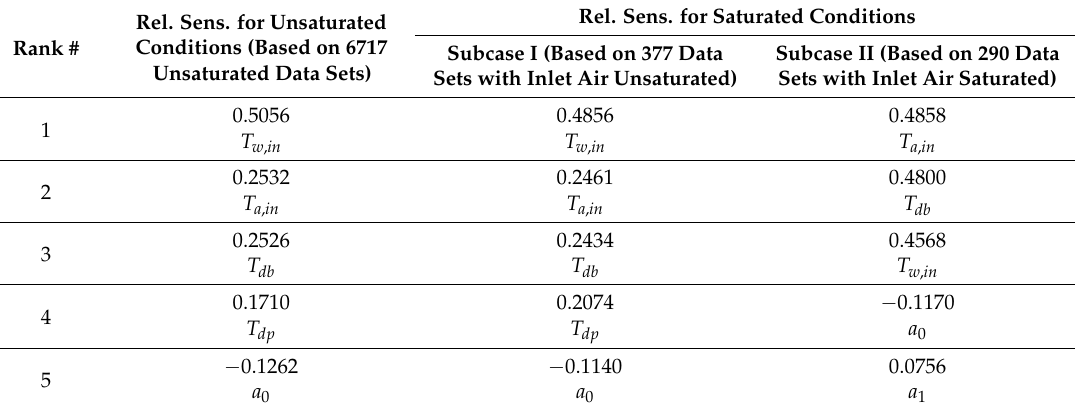
Table 8. Cross-comparison of the top five relative sensitivities for the response of water outlet ( 50 ) temperature, T w .